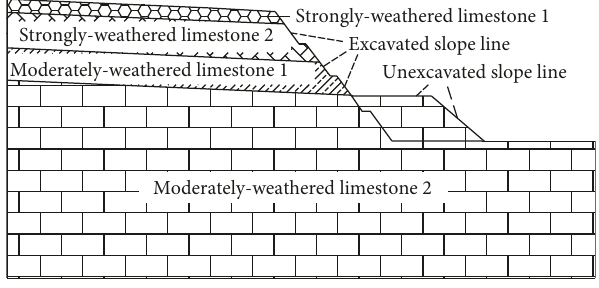
Figure 7: Slope profile.